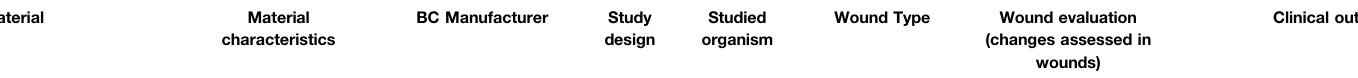
TABLE 3 | ( Continued ) Characteristics of BC and BC composites used in wound care — results of clinical